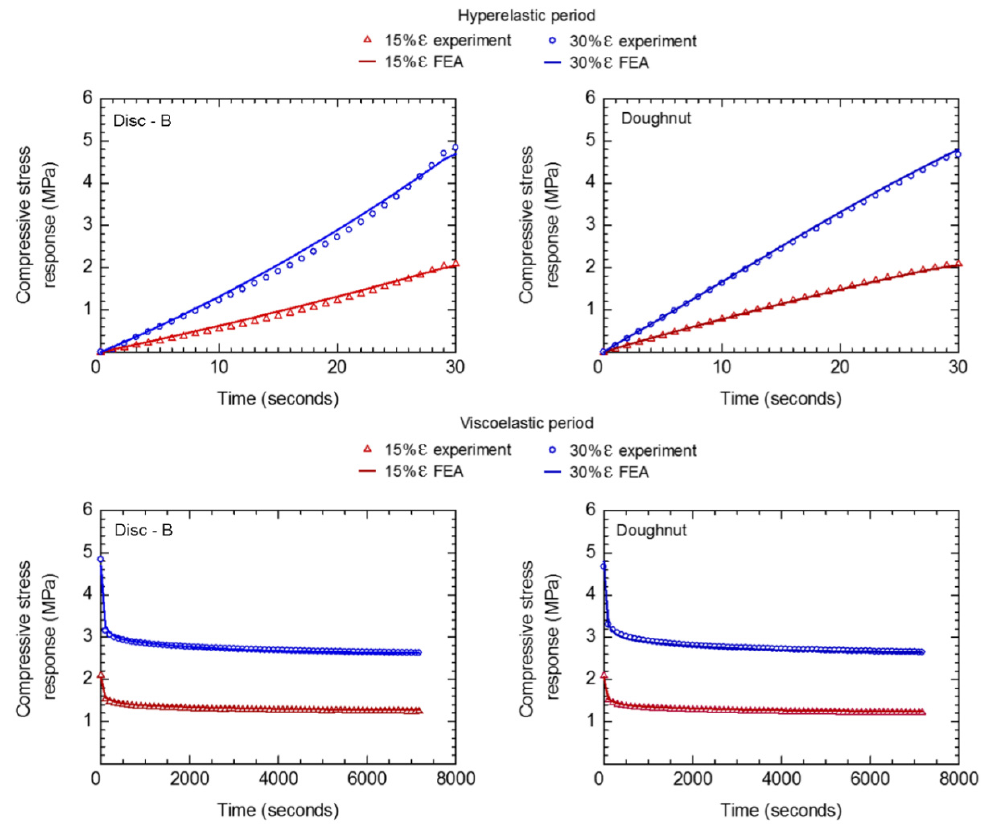
Figure 11. Comparisons between stress relaxation behaviors estimated from the FEAs and those from experiments.